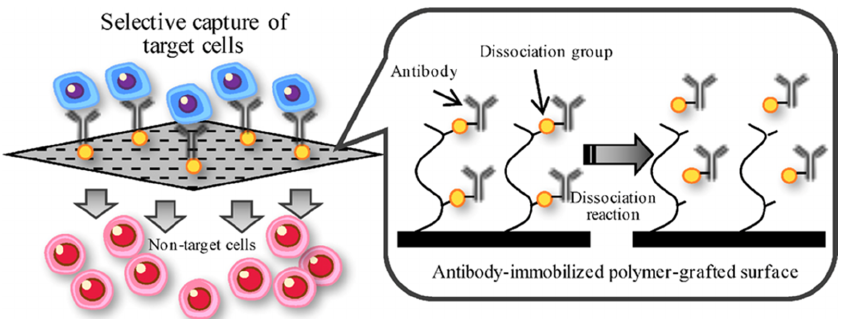
Figure 3. Representation of cell type-specific capture onto a surface using antibodies. Blue cells represent target cells, red cells represent non-target cells, yellow circle represents the dissociation group. Reproduced from [94].